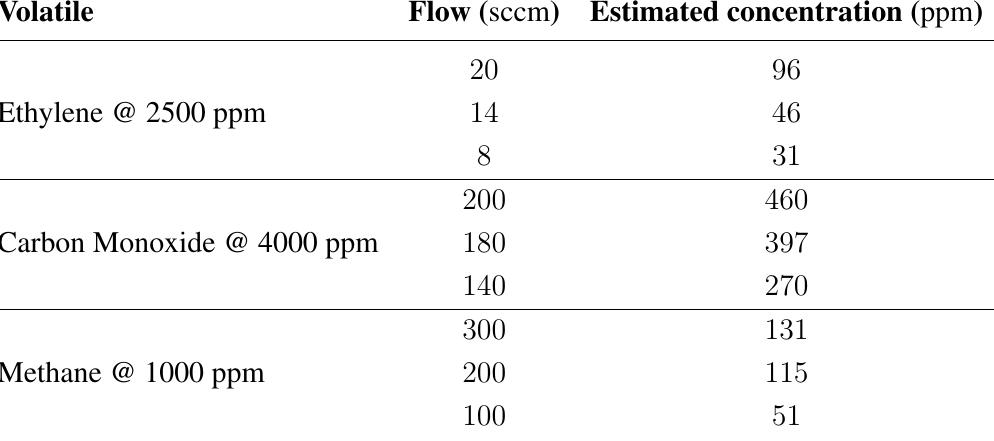
Table 3. Estimated mean concentration levels at the sensor